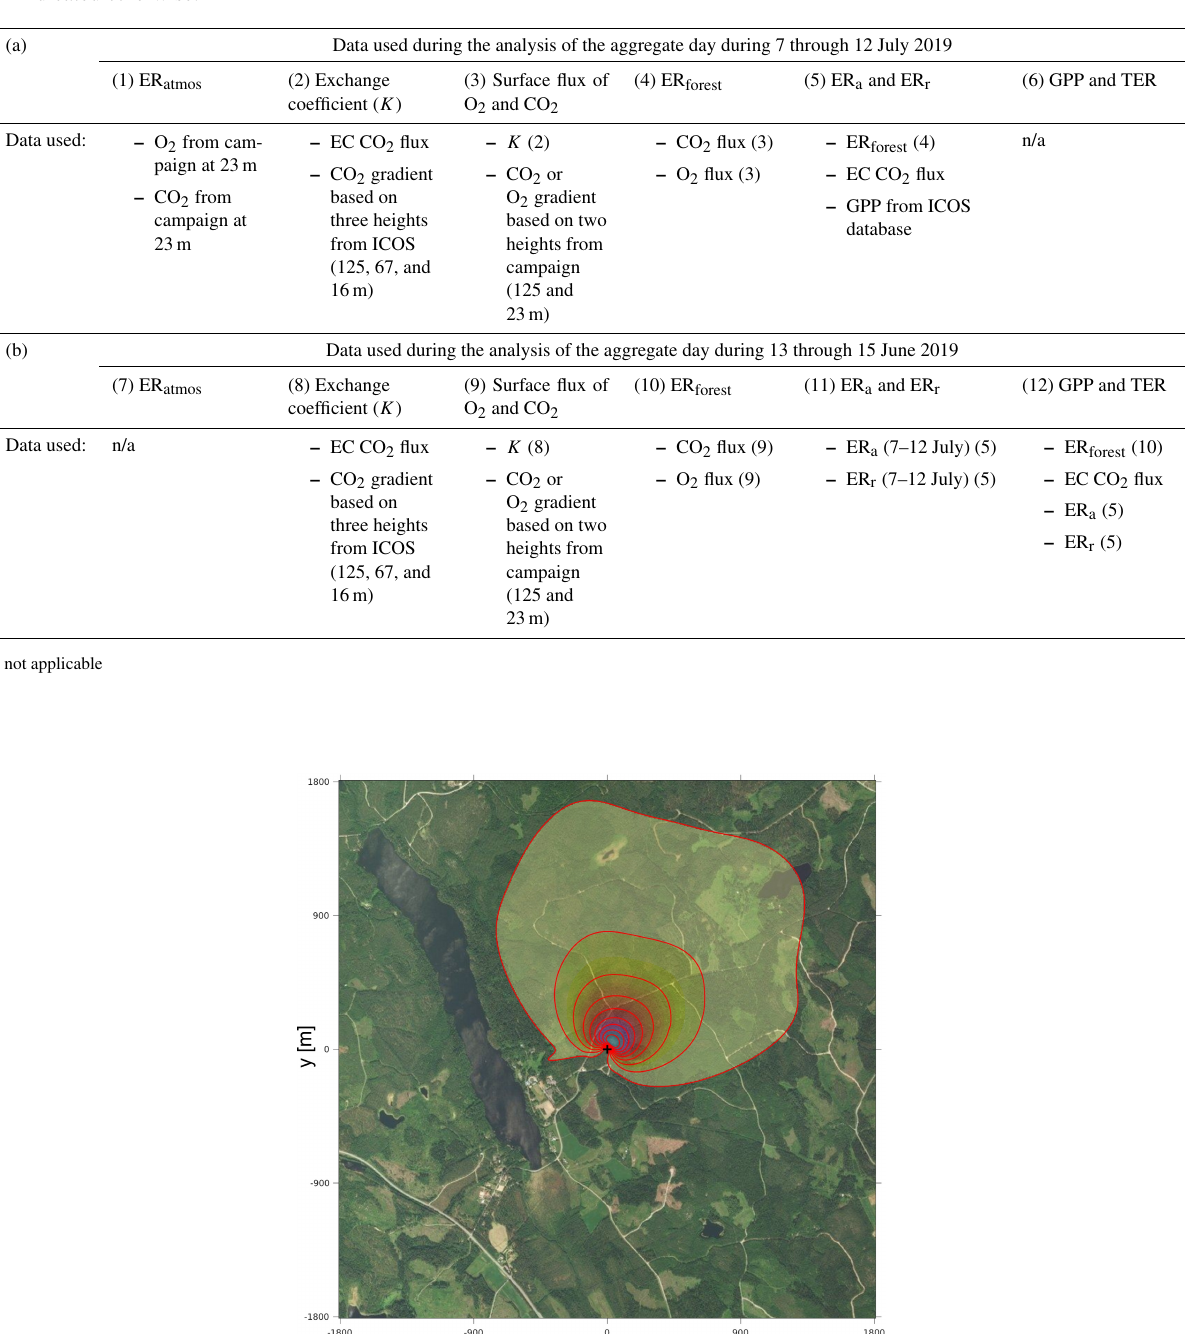
Table B1. Here are the data used to calculate different variables that we calculated in our study for the two aggregate days. Part (a) indicates the data that were used for the first representative aggregate day during 7 through 13 July 2019, and part (b) indicates the data that were used for the second aggregate day between 13 and 15 June 2019. The data used are mostly from the period of the respective aggregate day, except when indicated otherwise.